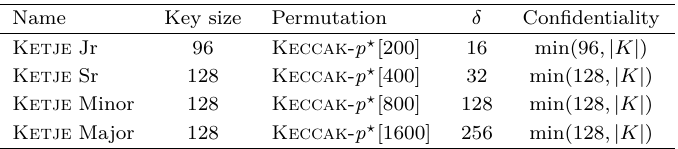
Table 2: Four instances of Ketje